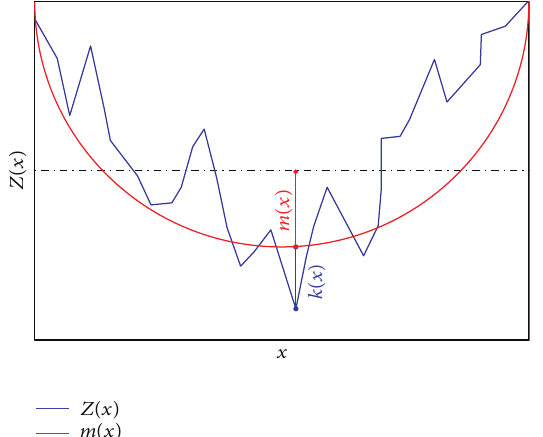
Figure 1: Regionalized variable schematic representation.